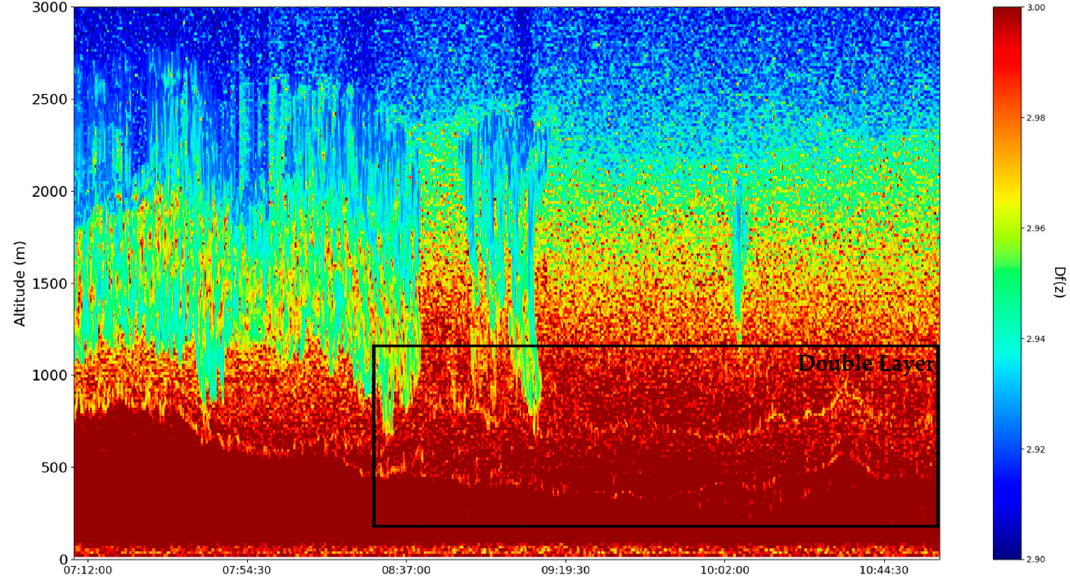
Figure 22. Zoomed-in (region of interest) D (cid:2916) time series, λ = 1064 nm , Gala ț i, Romania, 23 Decem- ber 2021.